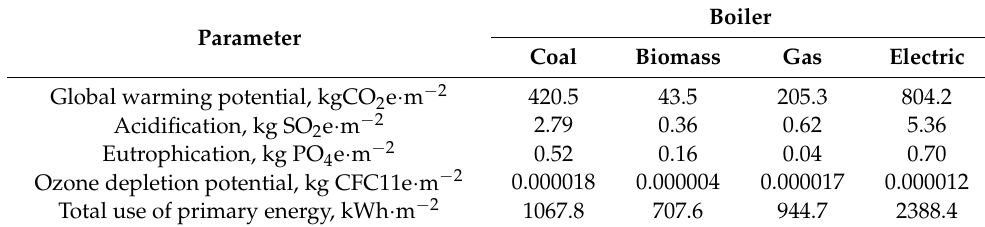
Table 3. Environmental impact factors for the operational stage over 25 years (BPASS case). Parameter